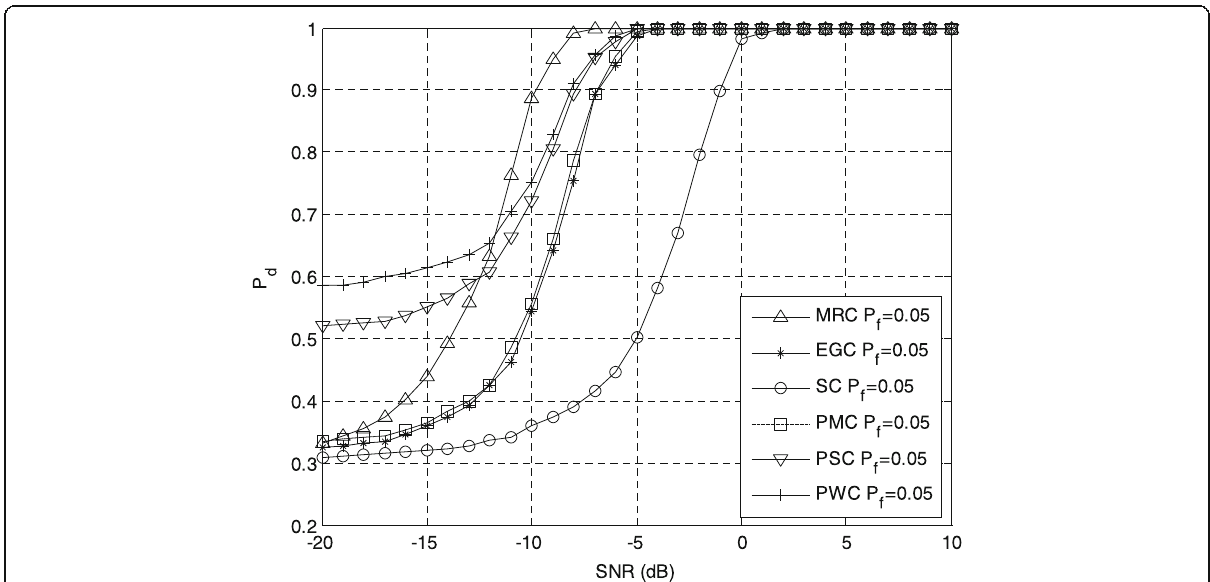
Fig. 10 Performance comparison of the pre-combining detection algorithm and proposed combining algorithm when P f = 0.05